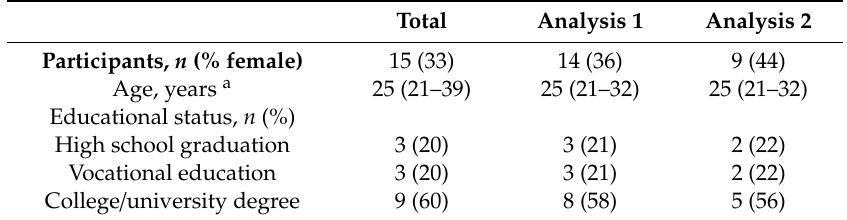
Table 4. Demographic characteristics of study participants who entered three sample meals into myfood24-Germany ( n =